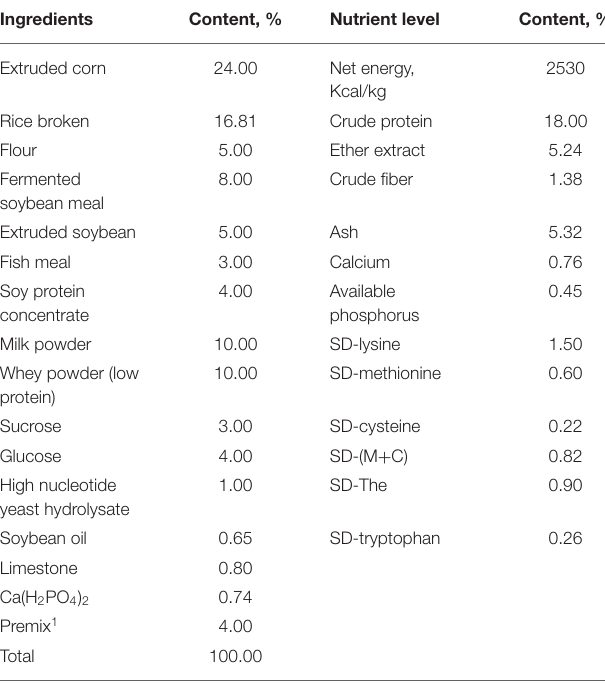
TABLE 1 | Ingredients and nutrient composition of the basal diet.